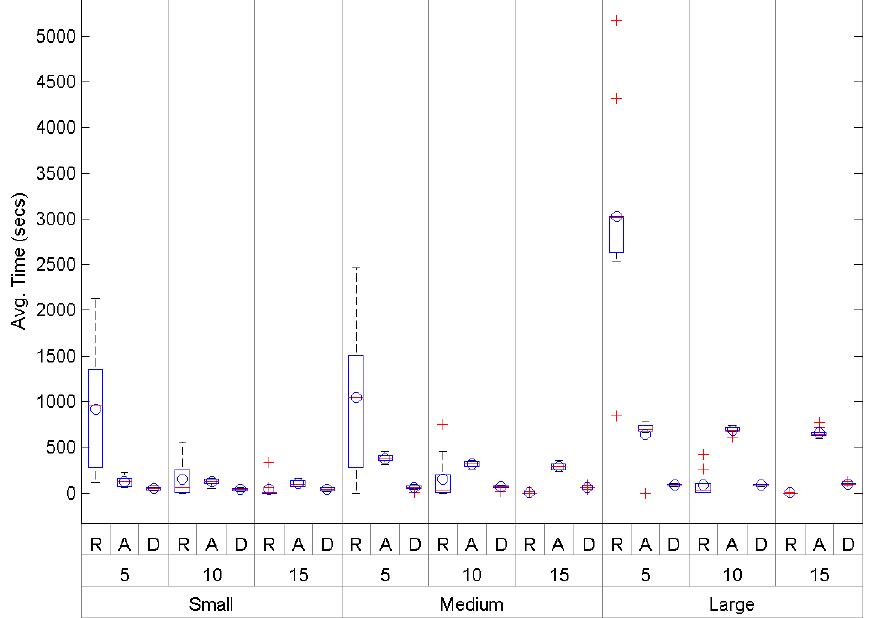
Figure 12. Convergence time results for small-, medium- and large-size scenarios. Table 3. Average convergence time (seconds (secs)) in small-, medium- and large-size